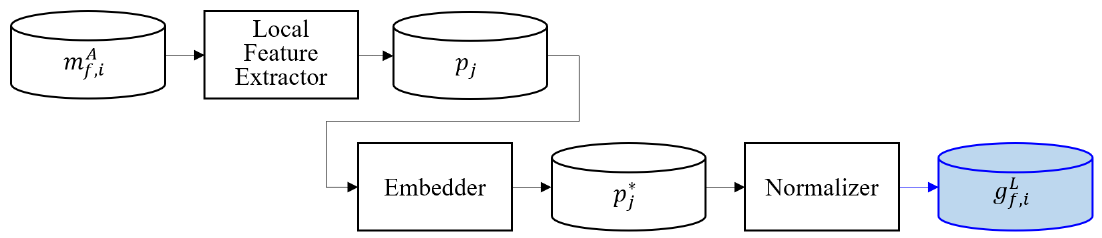
Figure 2. Local feature visualization process.